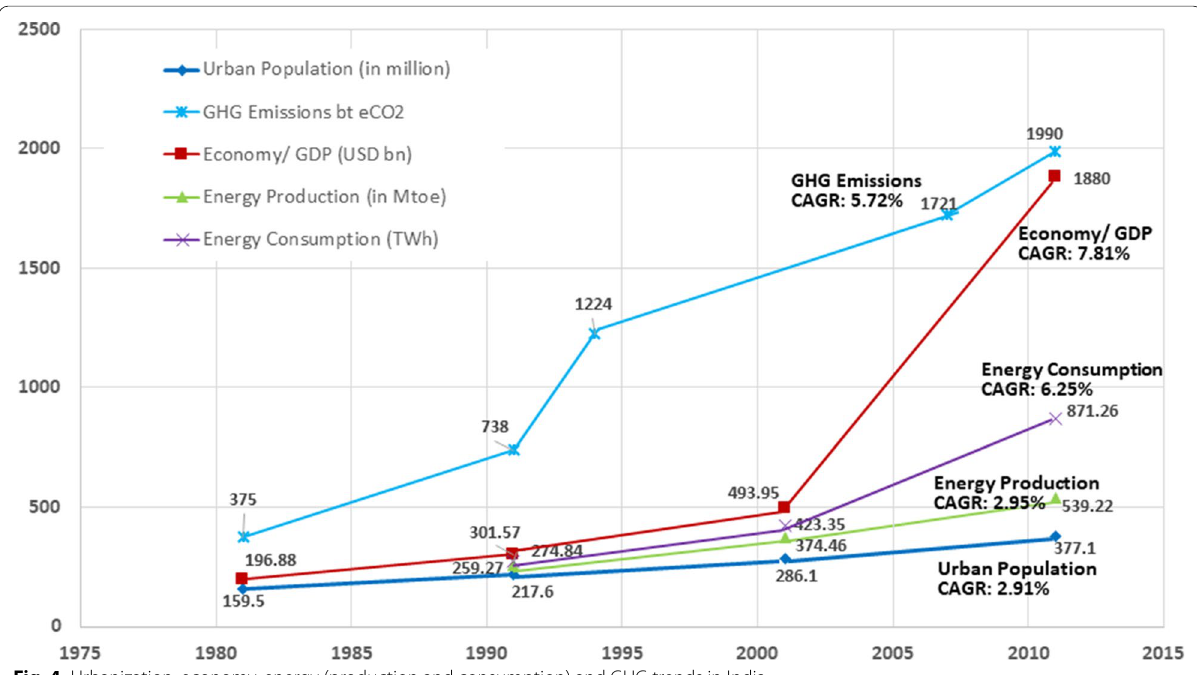
Fig. 4 Urbanization, economy, energy (production and consumption) and GHG trends in India Source: The time series analysis is generated based on the following point data sources: 1. Urban Population data from TCPO (2012), ‘Data Highlights (Urban) based on Census of India’, Town & Country Planning Organisation, Government of India, New Delhi. 2. Energy Consumption and Production figures for 1991, 2001 and 2011 from IEA database available at http:// www. iea. org/ stati stics/ stati stics search/ repor t/? count ry indic ators & year 1991 3. GHG emissions data (1994 & 2007) from MoEF (2010): ‘India: Greenhouse Gas Emissions 2007’, Indian Network for Climate = Change Assessment, MoEF, India. Figures for 1981, 1991 are from World Bank indicators, see point 4 below. 4. Economic baseline in current USD from World Bank indicators available on http:// data. world bank. org/ indic